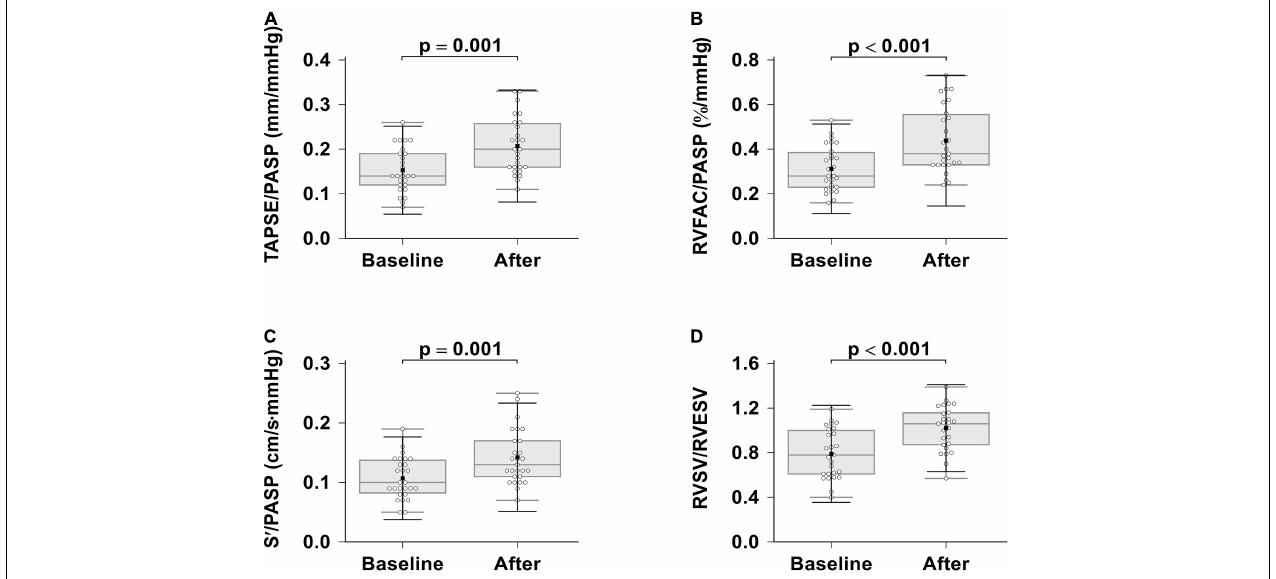
FIGURE 3 | Effects of ambrisentan plus PDE-5i combination therapy on right ventricular pulmonary arterial coupling. (A) TAPSE/PASP; (B) RVFAC/PASP; (C) S’/PASP; (D) RVSV/RVESV. TAPSE, tricuspid annular plane systolic excursion; RVFAC, right ventricular fractional area change, S’, tricuspid annular systolic velocity; PASP, systolic pulmonary artery pressure, RVEF, right ventricular ejection fraction; RVESV, right ventricular end-systolic volume; RVSV, right ventricular stroke volume. TABLE 5 | Correlation of right ventricular pulmonary arterial coupling to functional status. RVPAC Correlation with NT-proBNP Correlation with WHO FC Correlation with